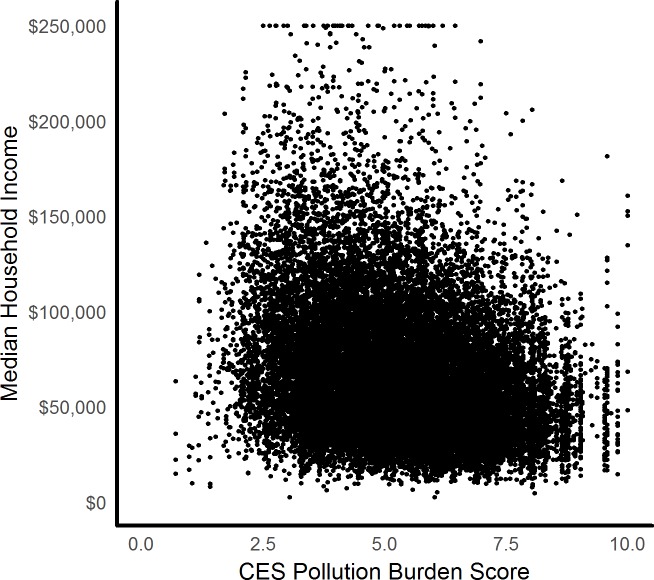
Median household income and CES pollution burden scores for all 23,312 California block groups (r = -0.29).Though low pollution burdens are present at all socioeconomic levels, greater pollution burdens are largely constrained to low-income block groups.